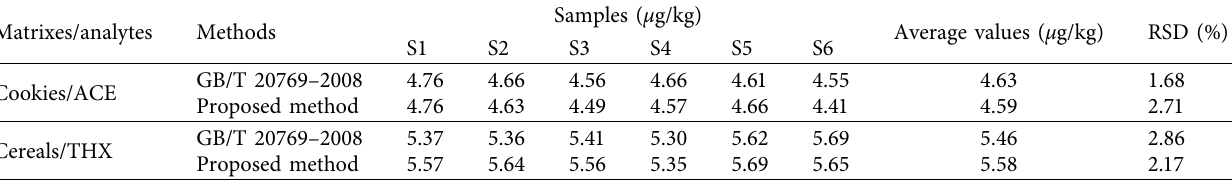
Table 4: Results of neonicotinoids determination in infant foods measured by the GB method and proposed method. Matrixes/analytes